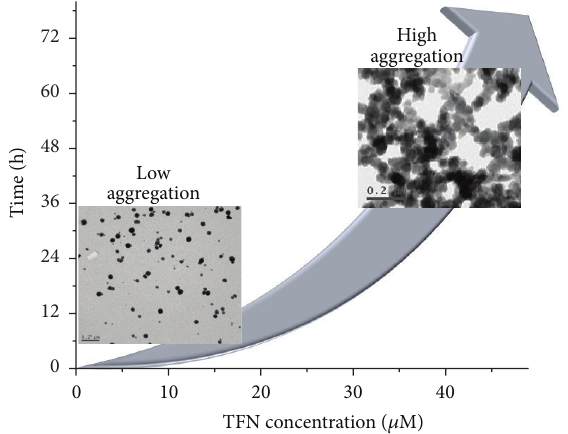
therefore slow drug release depending on time and TFN concentra- tion. Inserts show TEM micrographs of TFN-loaded nanovesicles; scale bar is 0.2 𝜇